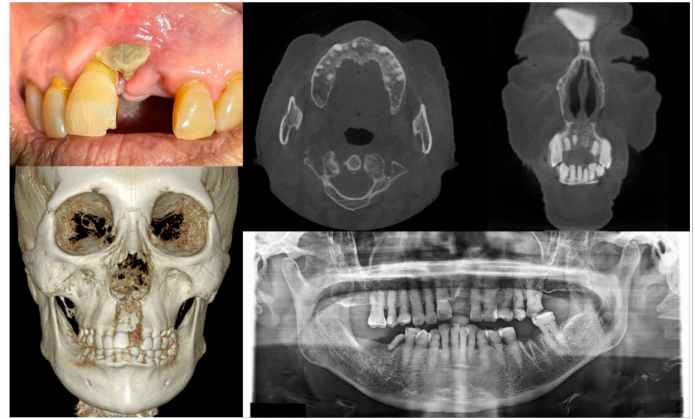
Figure 2. Case 2 with MRONJ Stage 1: Clinical photo, panoramic view, and computed tomography imaging including three-dimensional reconstruction showing exposed alveolar bone on the anterior maxillary area. An 89-year-old female patient with a history of oral alendronate for more than four years and intravenous administration of denosumab for one year showed the exposed bone after extracting the left upper central incisor three months ago. She reported no symptoms such as pain other than exposed bones. There was no sign of infection, including pus discharge on the exposed bone.